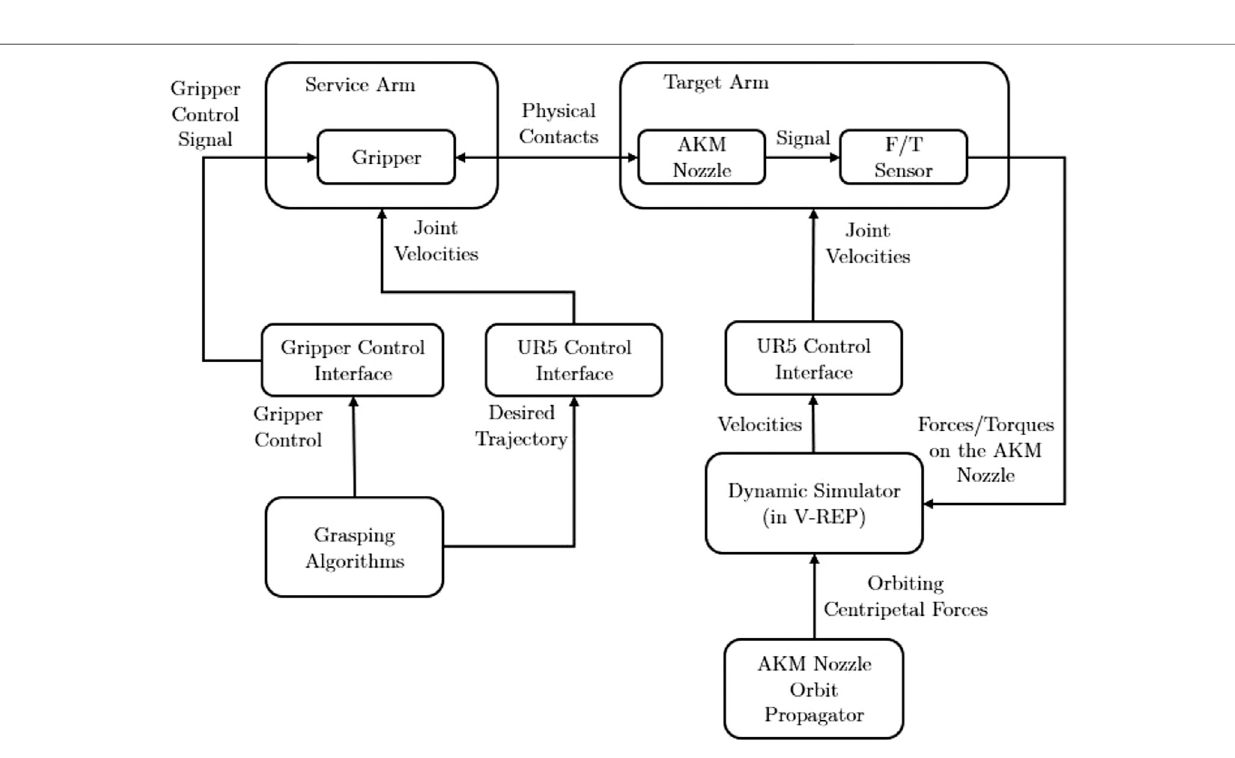
Frontiers in Robotics and AI |